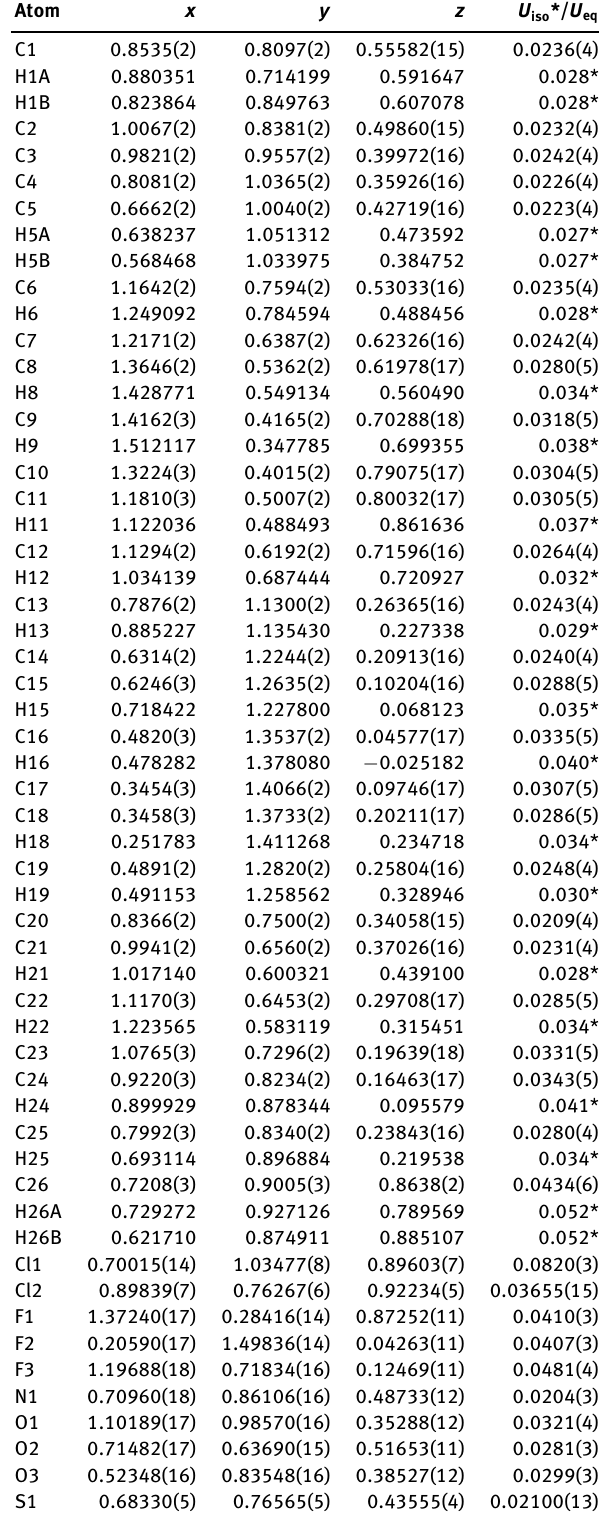
Table 2: Fractional atomic coordinates and isotropic or equivalent isotropic displacement parameters (Å 2